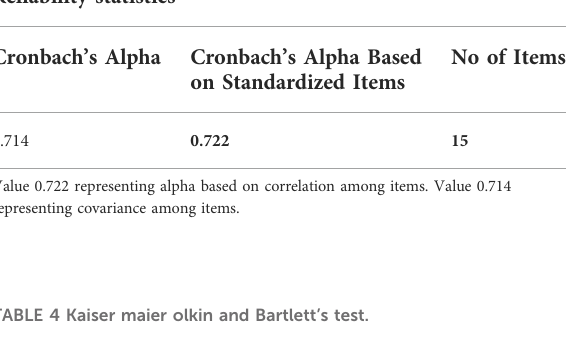
TABLE 3 Cronbach ’ s alpha reliability test.